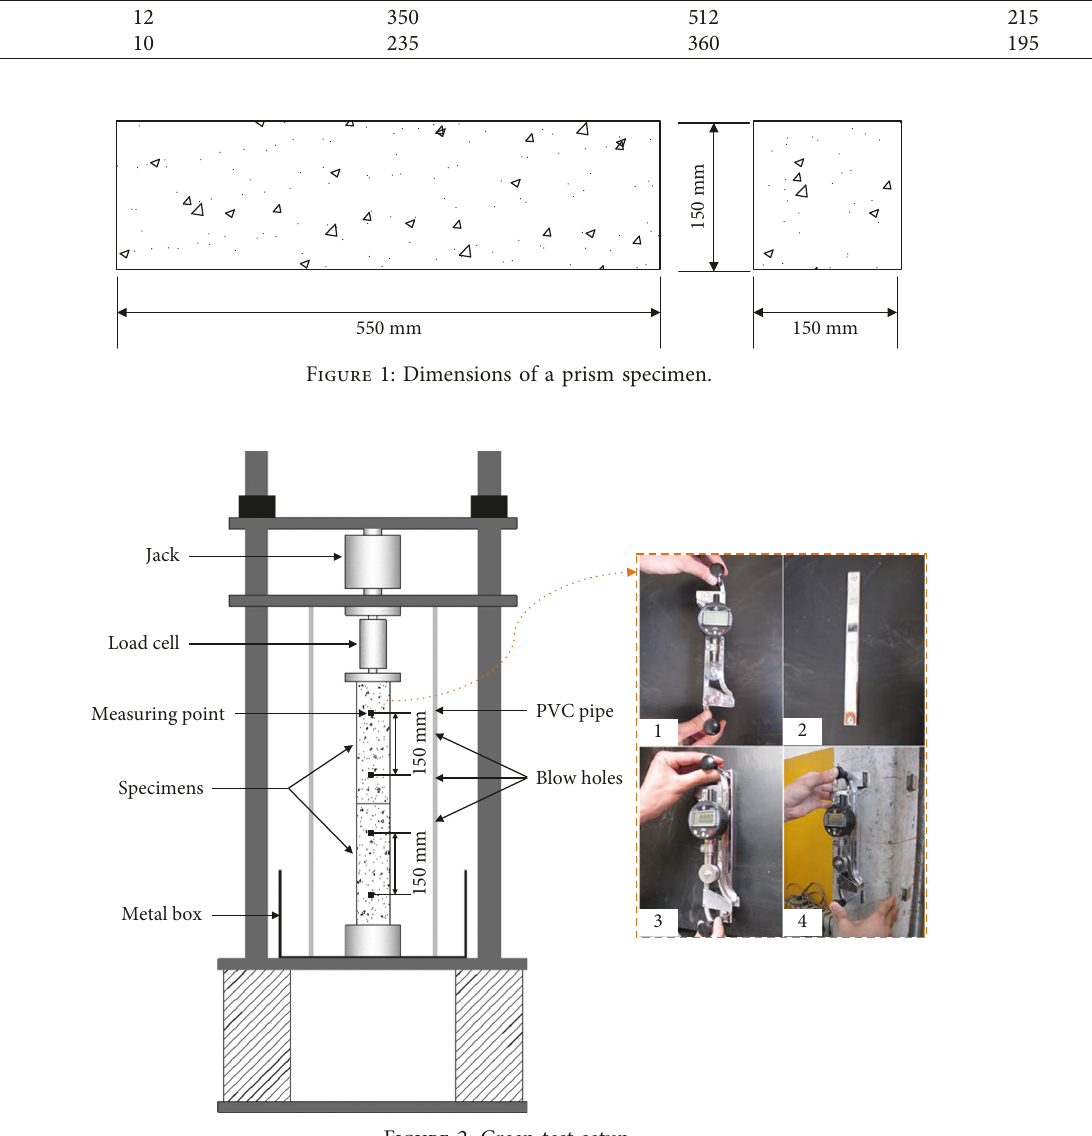
Figure 2: Creep test setup.